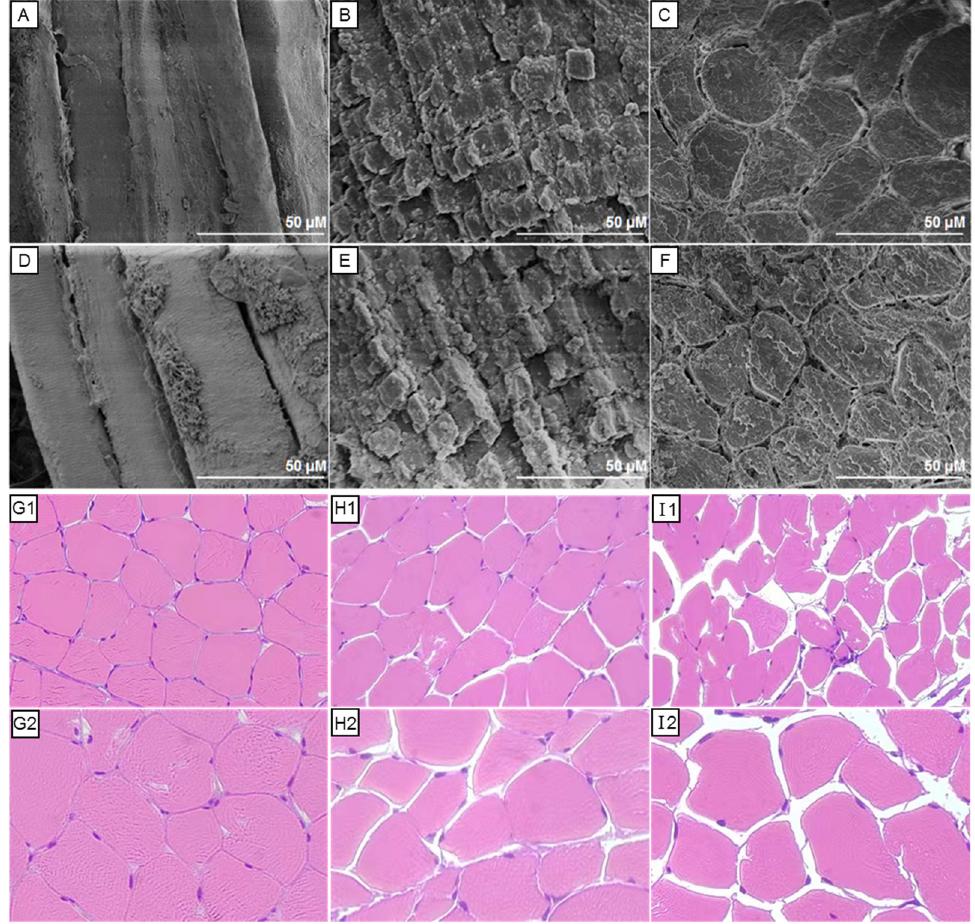
Figure 4. Characterization of muscles via SEM and H&E staining. ( A , B ) Longitudinal section and ( C ) cross-section analysis of mutton cooked in ordinary pure water; ( D , E ) longitudinal section and ( F ) cross-section analysis of mutton cooked in nanobubble water. The H&E staining images of mutton muscles cooked in ( G1 , G2 ) ordinary pure water, ( H1 , H2 ) ice-melted water, and ( I1 , I2 ) nanobubble water, respectively. The photos labeled with number 2 are zoomed in from those labeled with number 1.